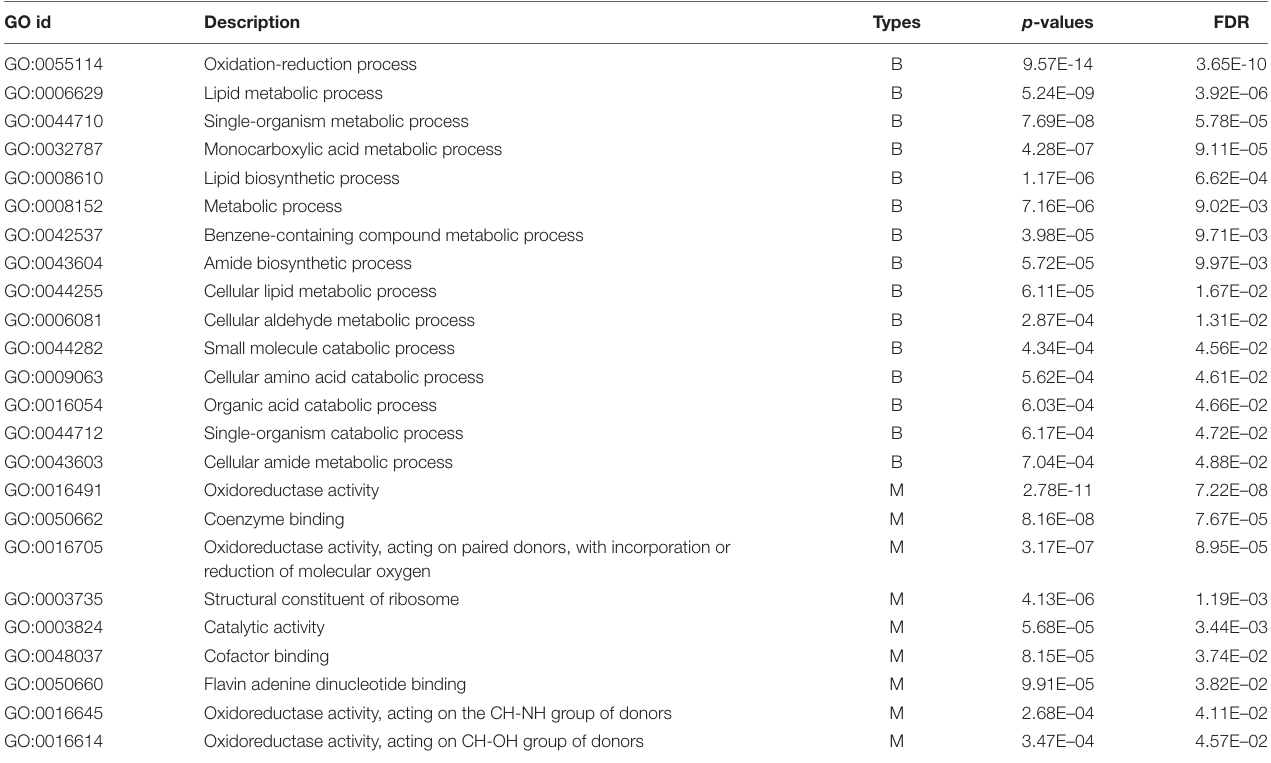
TABLE 4 | List of GO terms significantly enriched by differentially expressed genes in the treatment groups compared to the control groups. FDR = FDR-adjusted p -values. The Benjamini–Hochberg adjustment was used for FDR correction of the p -values (generated by Fisher’s Exact test) of all the GO terms. GO id Description